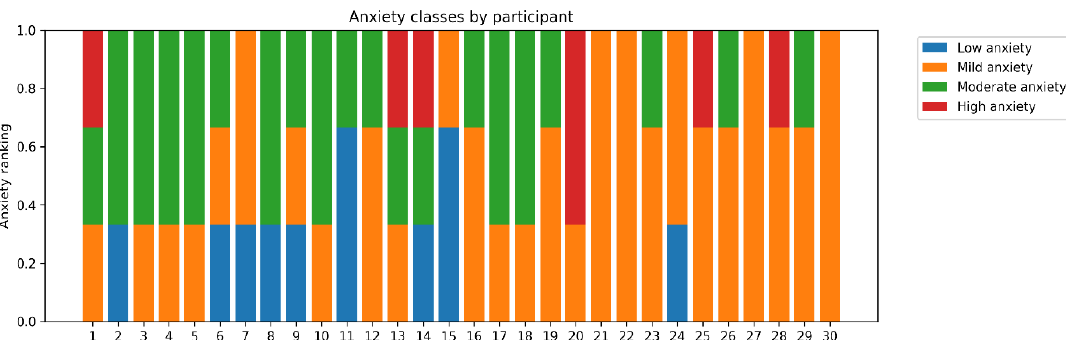
Figure 10. Results of leave-one-subject-out validation by each participant.